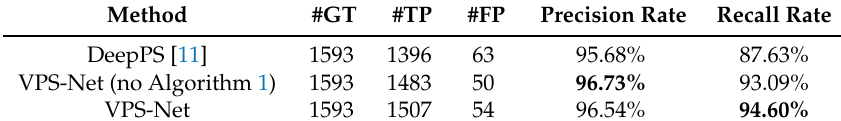
Table 9. Parking slot detection performance of different methods in the PSV test set.